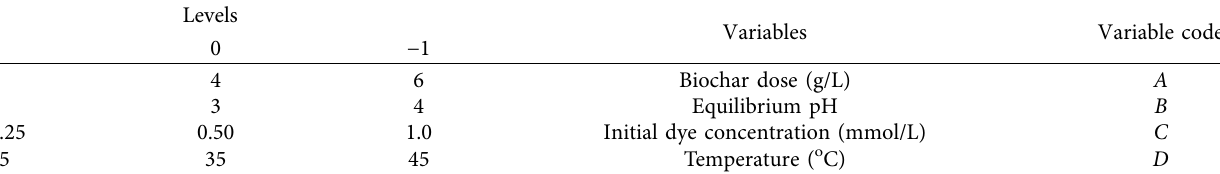
Table 1: BBD input variables with